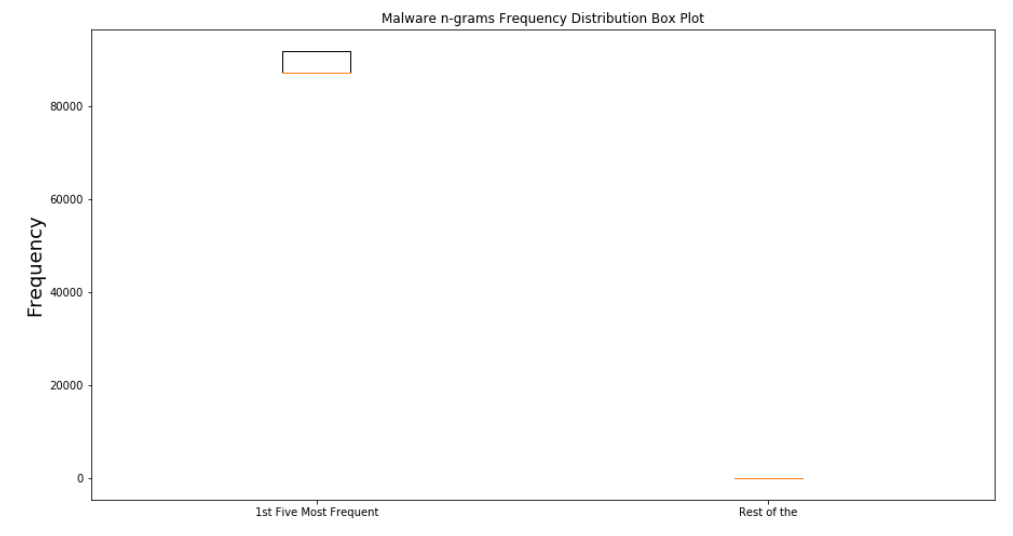
Figure 6. Malware API N-gram frequency